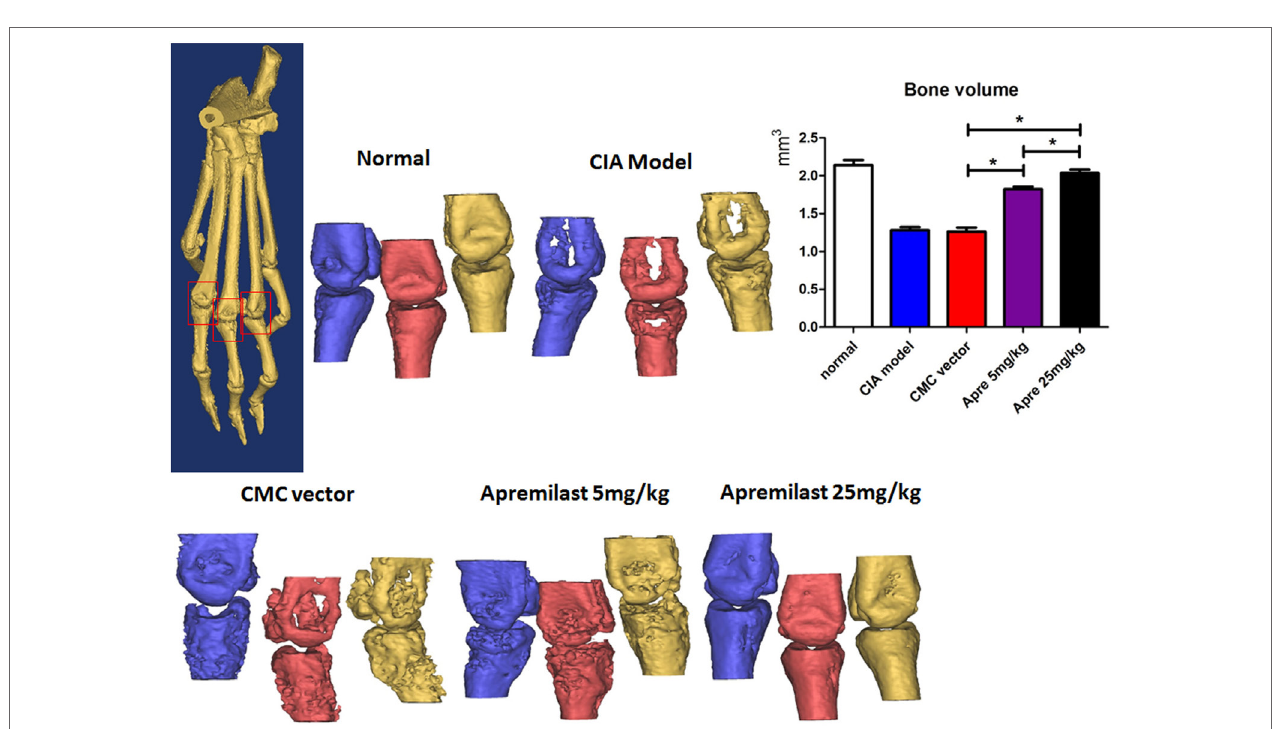
FigUre 3 | Apremilast prevented bone erosion in collagen-induced arthritis (CIA) model. Apremilast (5 or 25 mg/kg), CMC vehicle alone, CIA model, and normal groups mice were killed on day 56, the right hind limbs were collected and analyzed by the high-resolution micro-computed tomography (micro-CT) system (VivaCT 40). Second through fourth metatarsal and phalangeal bones were segmented from surrounding soft tissue using a consistent image intensity threshold. Three volumes of interest were set with ± 1 mm length in the distal and proximal direction from the center of each metatarsophalangeal joint. The bone volumes of the three metatarsophalangeal joints were then calculated. Representative micro-CT images were shown. The summary data are shown in the left panel. The data indicate the mean ± SEM of five mice per group from two independent experiments (* p < 0.05). Data were analyzed using the one-way ANOVA for comparison among multiple groups, followed by Turkey’s